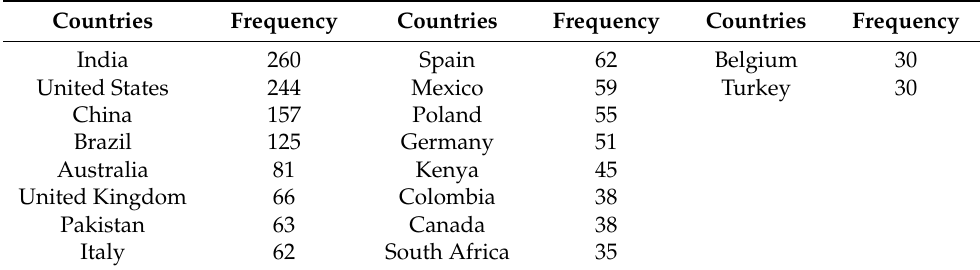
Table 3. Frequency of papers by review countries.